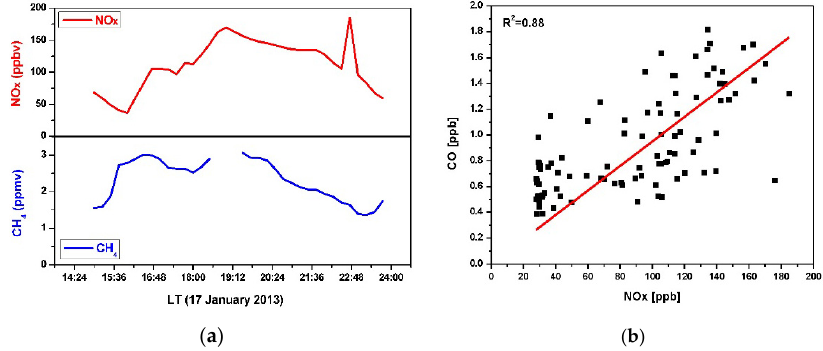
Figure 12. Correlation of NOx vs. CH 4 ( a ) and NOx vs. CO ( b ) during the period of the observed episode on 17th January 2013.